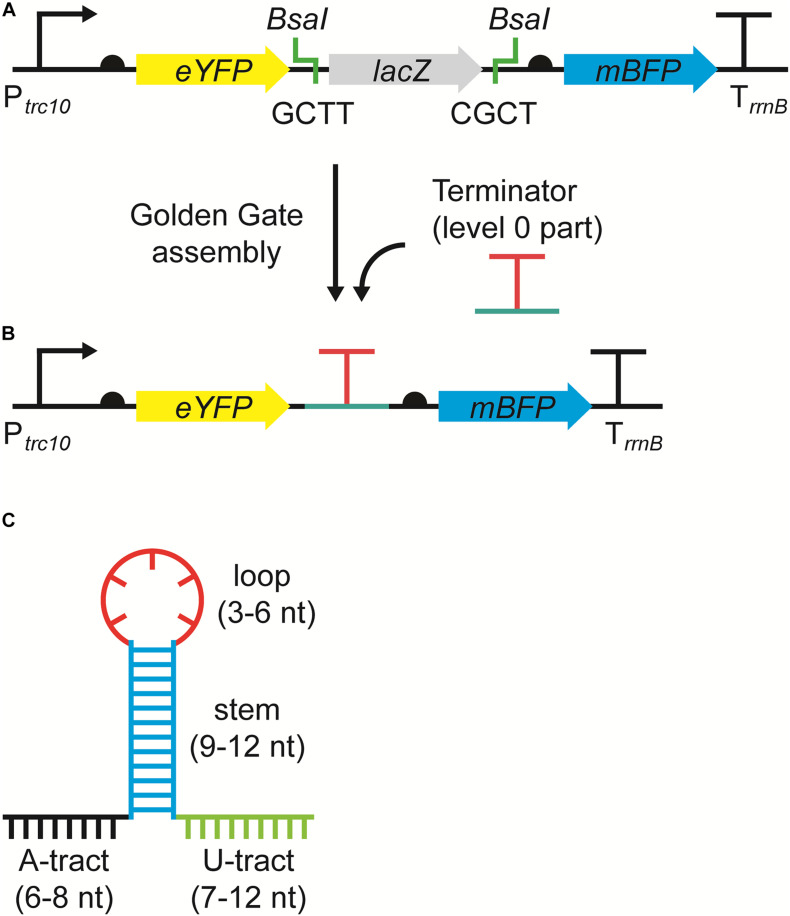
The dual fluorescence reporter system for screening terminators. (A) The acceptor vector pDUOTK1-L1 contains two BsaI sites that generate 4 nucleotide (nt) overhangs (i.e., GCTT and CGCT) following restriction, which are compatible with standard level 0 terminator parts (Engler et al., 2014). (B) Following a level 1 Golden Gate assembly reaction (Vasudevan et al., 2019), the level 0 terminator part is inserted between eYFP and mTagBFP and the dual fluorescent reporter system is formed, which can then be used to evaluate termination efficiency (TE). The reporter system is driven by the strong promoter Ptrc10 and is terminated by the terminator TrrnB. Ribosome binding sites (half circles) are indicated (see Supplementary Information S1 for sequence details). (C) Example of an intrinsic terminator structure and nt sequence, comprised of an adenine rich region (A-tract) (black), followed by a G-C rich stem (blue), a hairpin loop (red), and a uracil rich region (U-tract) (green).